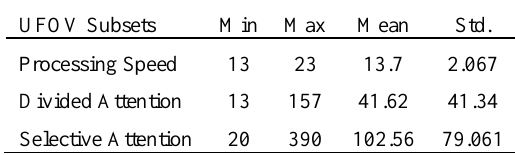
Descriptive statistics of UFOV scores (unit as milliseconds). UFOV Subsets Min Max Mean Std.